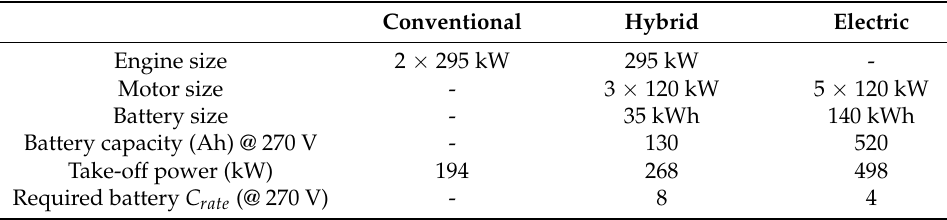
Table 2. Specification of today’s powertrains.